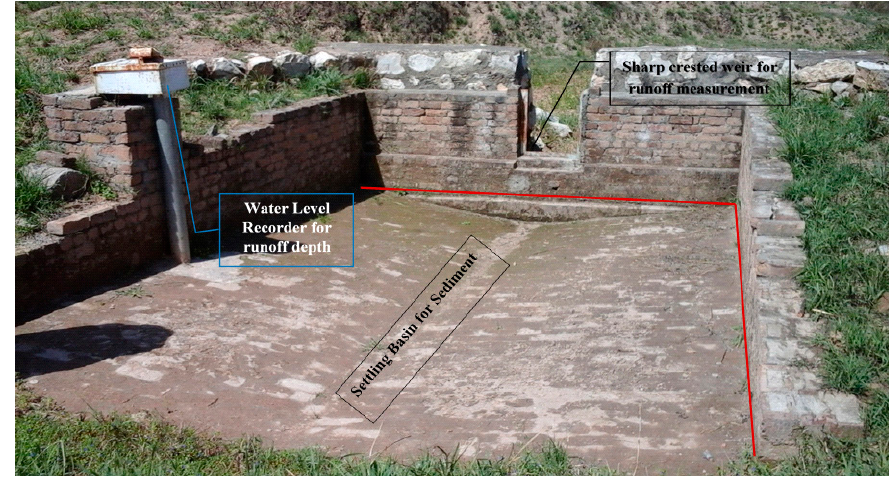
Figure 5. The experimental setup for runoff and sediment yield [14].